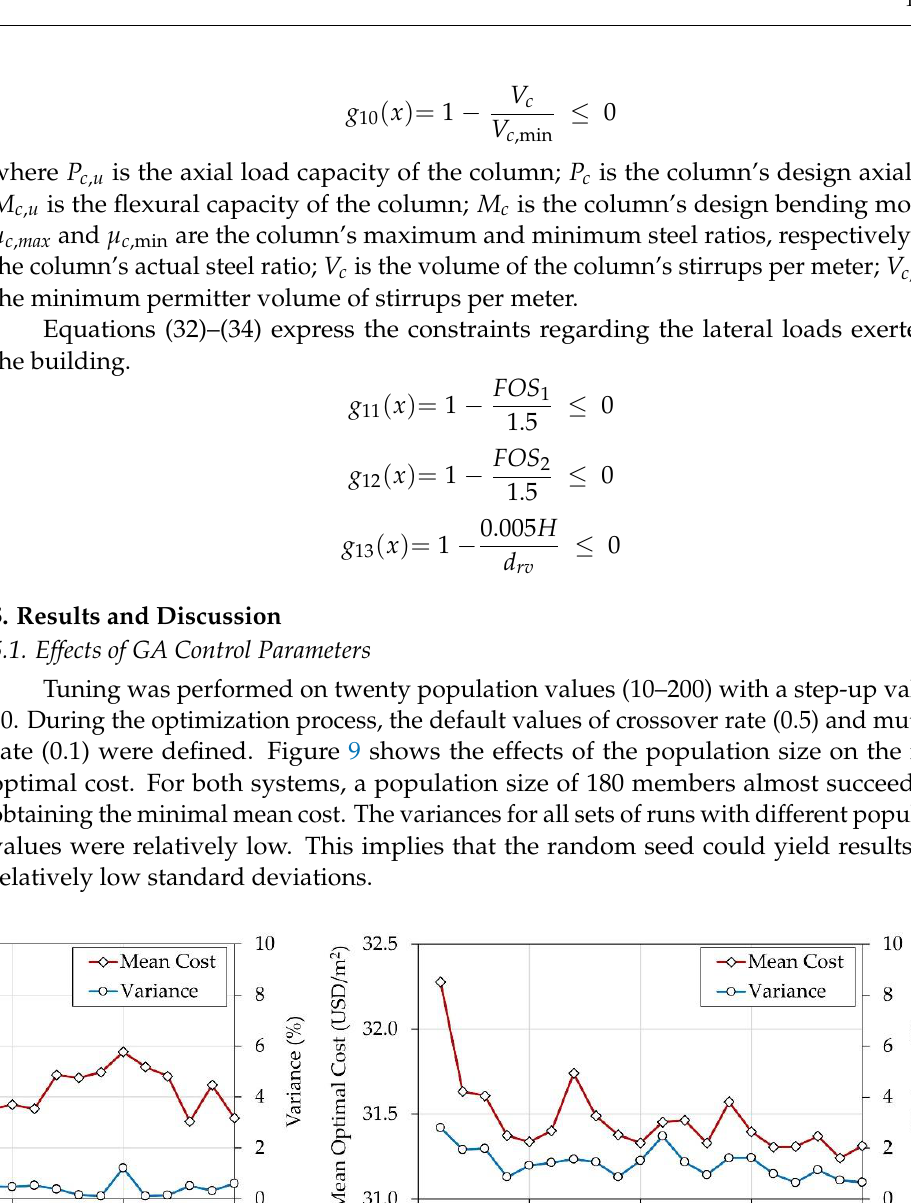
( b ) Figure 10. Effects of crossover rate on mean optimal cost: ( a ) FSWD; ( b ) FS. During the optimization process, the default values of the population size (200) and crossover rate (0.5) were defined, and nine values were considered (0.1 – 0.9), with a step- up value of 0.1 to tune the mutation rate parameter. Figure 11 displays the effects of the mutation rate on the mean optimal cost. The presented mutation – cost relationship shows that raising the mutation rate, to an extent, does not positively impact the mean optimal cost of the building regardless of the floor system. Both floor systems had a minor vari- ance. Hence, a mutation rate of 0.1 could be adequate to shorten the algorithm ’ s compu- tational effort while maintaining good optimal results.